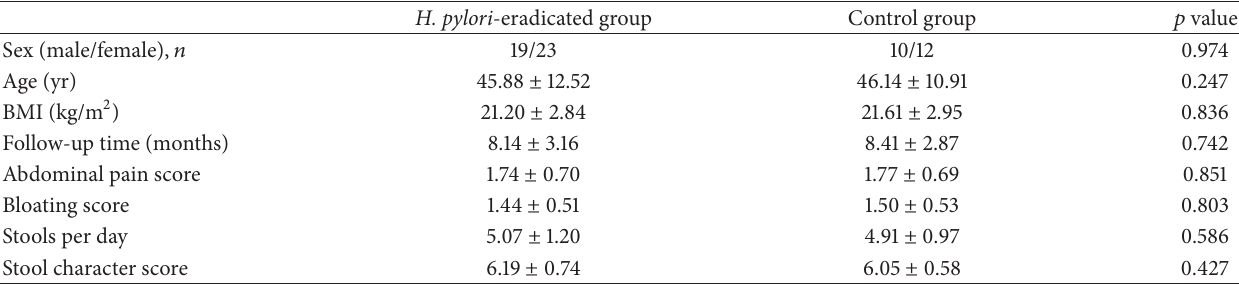
Table 3: Baseline characteristics in the H. pylori -eradicated group and the control group in patients of long-term